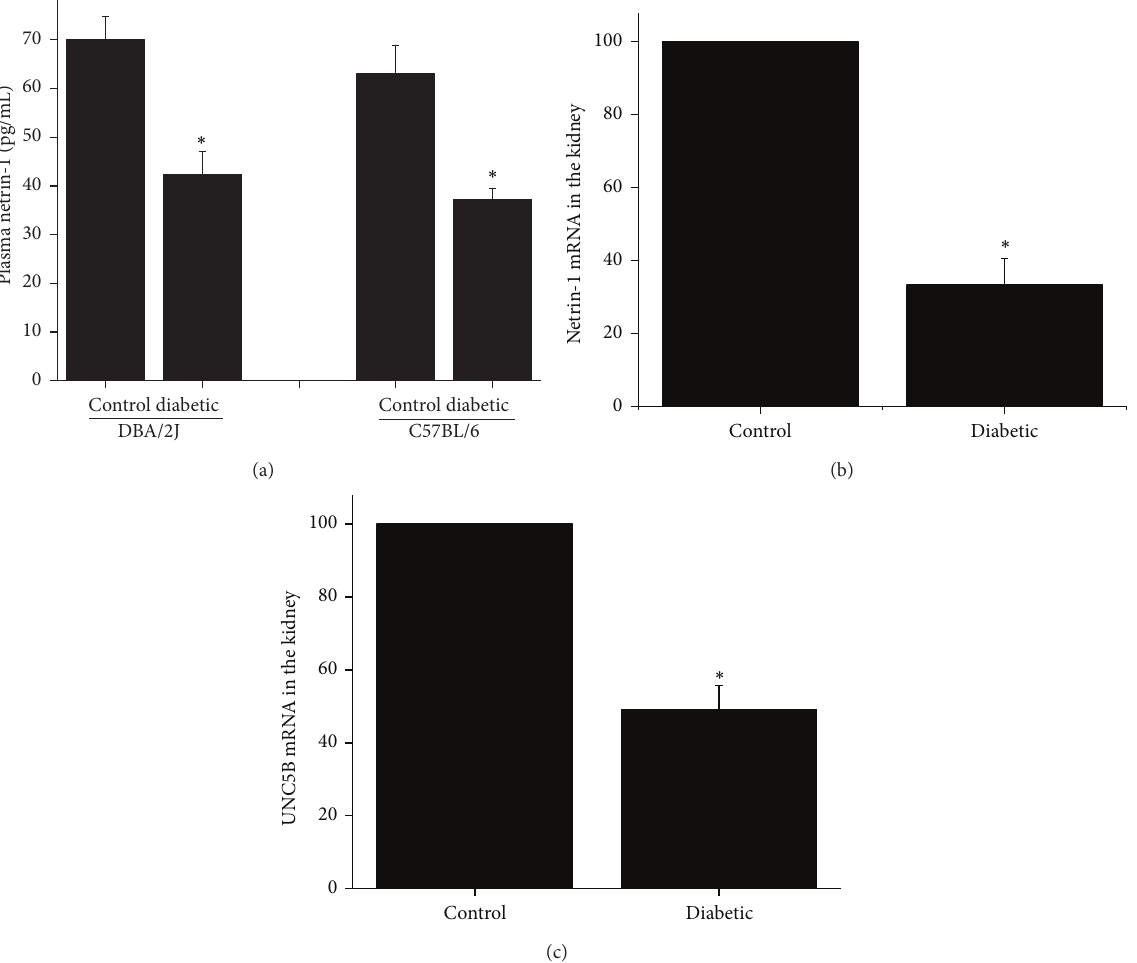
Figure 3: Diabetes downregulates endogenous anti-inflammatory protective pathways. (a) Diabetes (8 weeks after STZ administration) downregulated plasma netrin-1. ∗ 𝑃 < 0.001 versus nondiabetic control. 𝑛 = 5 . Netrin-1 in plasma was quantified by ELISA. (b) and (c) RT- PCR analysis of netrin-1 and UNC5B expression in control and 12-week diabetic mouse. Diabetes downregulated netrin-1 (C) and UNC5B (G) expression in the kidney. ∗ 𝑃 < 0.001 versus control. 𝑛 = 5